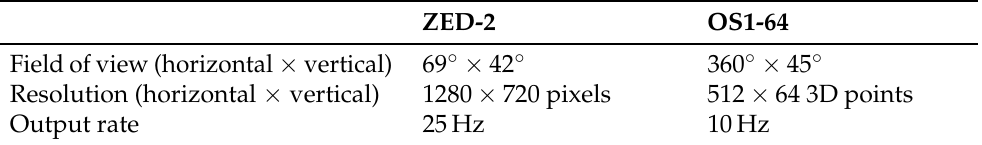
Table 1. Main specifications of the ZED-2 cameras and of the OS1-64 LiDAR.